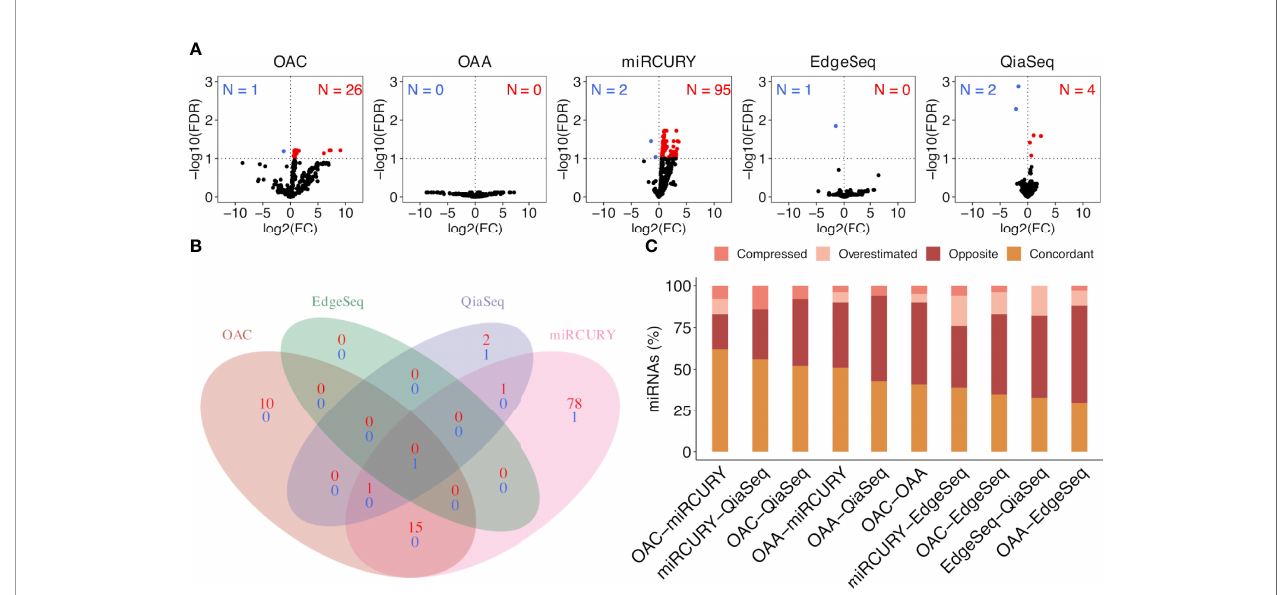
FIGURE 4 | Signi fi cantly dysregulated ct-miRs in non ‐ small cell lung cancer (NSCLC) patients compared with healthy donors and fold change concordance evaluation. (A) Volcano plots showing DE ct-miRs between lung cancer patients and healthy donors. The x-axis shows the log2 fold change. The y-axis shows the – log10 of the false discovery rate. A false discovery rate of <0.1, represented by a horizontal dashed line, is used to select DE ct-miRs. The up- and downregulated ct-miRs in lung cancer patients are highlighted in red and blue, respectively. (B) Venn diagram reporting the intersection of the ct-miRs signi fi cantly upregulated (red) and downregulated (blue) in lung cancer patients across the platforms. (C) Stacked bar plots showing the concordance in fold changes between platform pairs expressed in percentage of miRs. The four indices —” compressed ” , “ opposite ” , “ overestimated ” , and “ concordant ”— are described in “ Materials and Methods ”